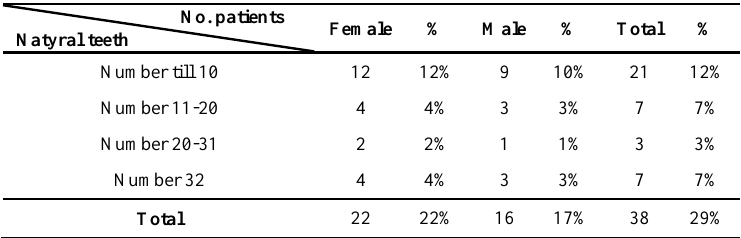
Table 4. Gender-replaced tooth number data, for the first and second group of patients